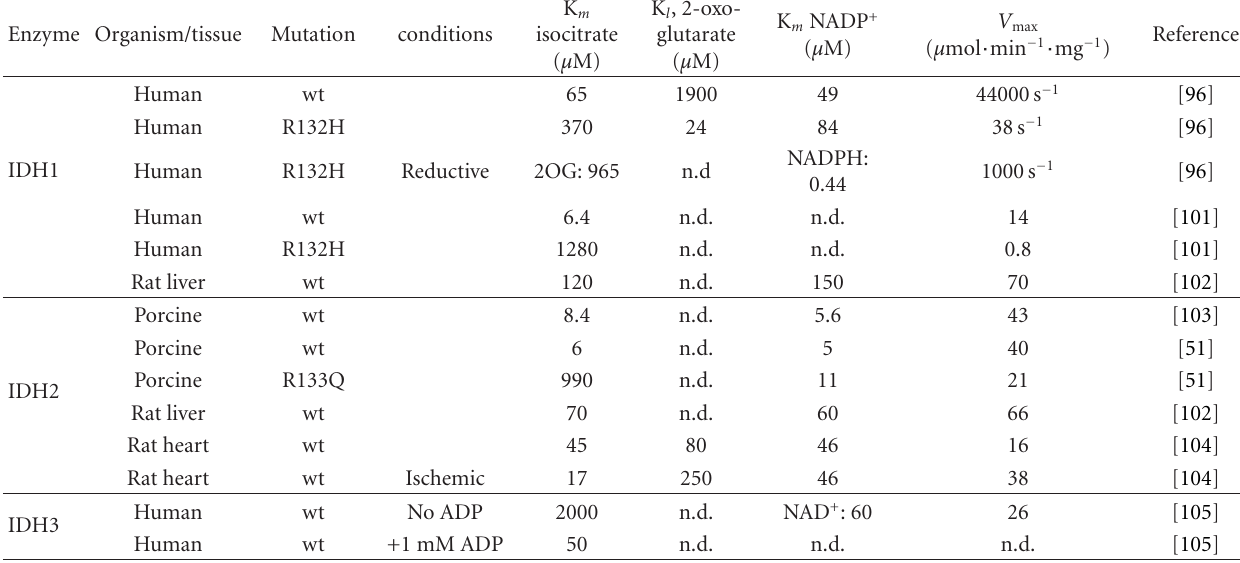
Table 1: Kinetics of IDH isoforms as compared to homodimeric mutant enzymes with clinically relevant mutations. Unless specified “re- ductive”, forward reactions were measured. “n.d.”: not determined. Enzyme